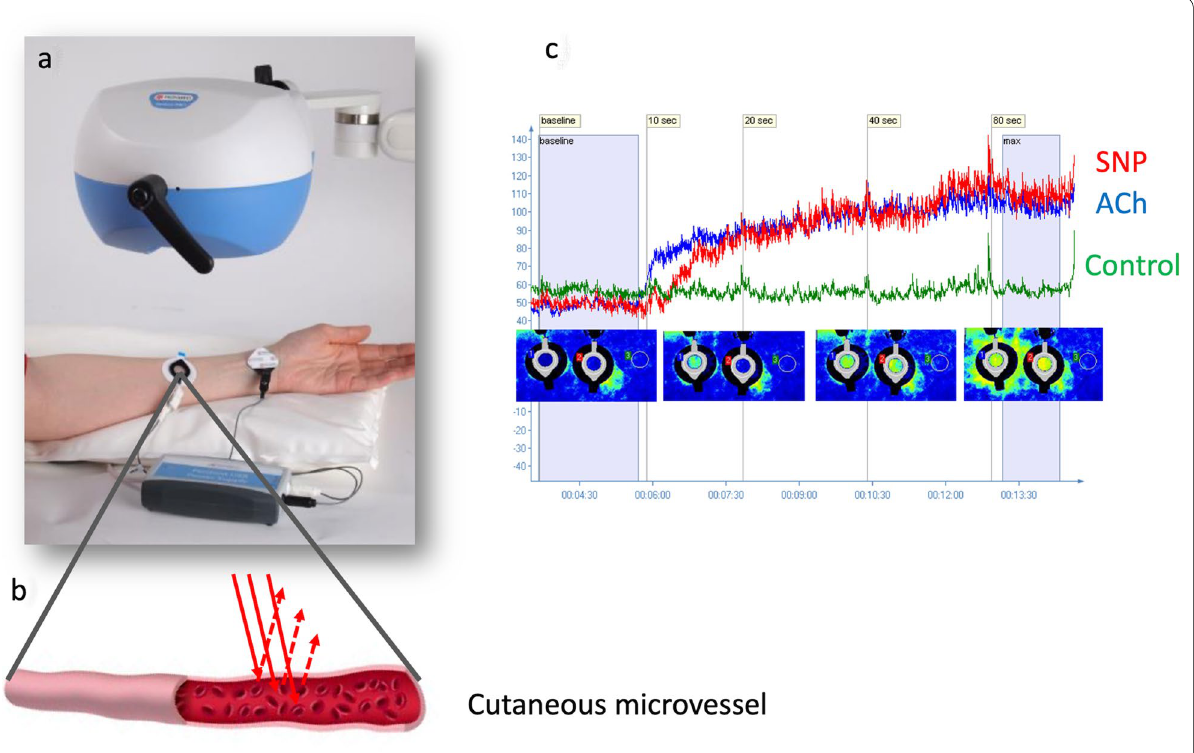
Fig. 1 Evaluation of cutaneous microcirculation. a Iontophoresis in combination with blood perfusion imager. b Incident light from the laser (thick red arrows) are scattered back (dotted arrows) from red blood cells flowing in the microvessels. c Typical dose–response-related vasodilatation as a response to ACh (blue) and SNP (red)—blood perfusion imaging. Photos reproduced with the permission of Perimed (Järfälla,